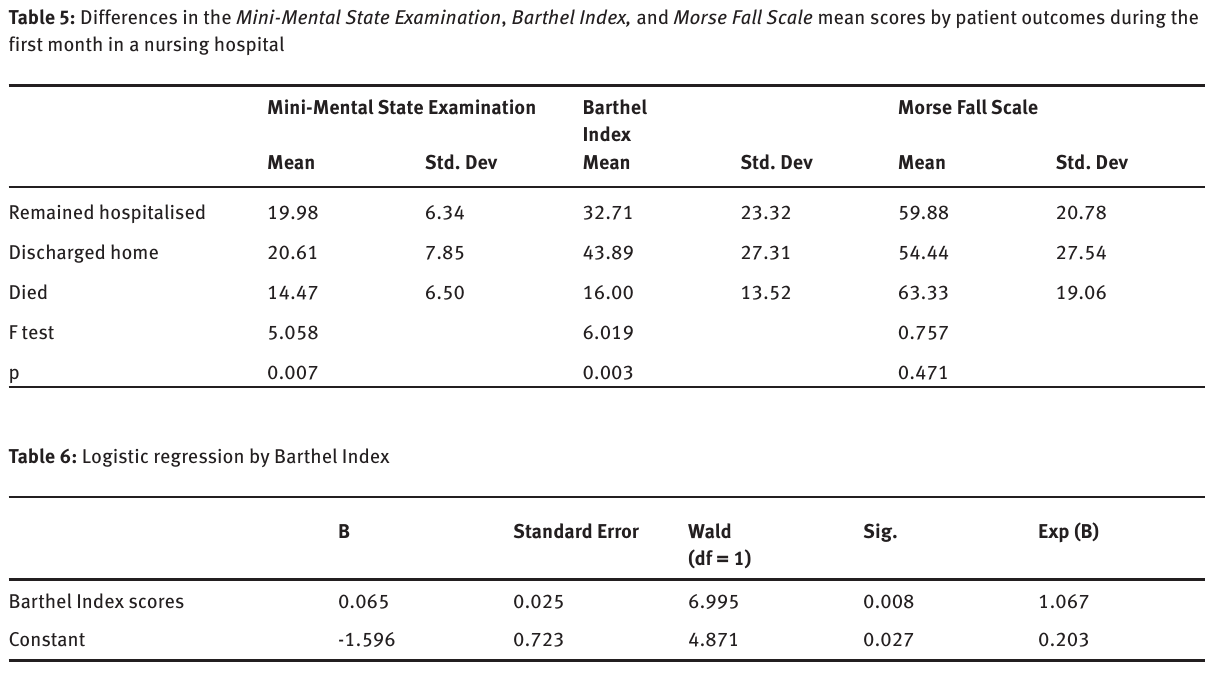
Table 5: Differences in the Mini-Mental State Examination , Barthel Index, and Morse Fall Scale mean scores by patient outcomes during the first month in a nursing hospital